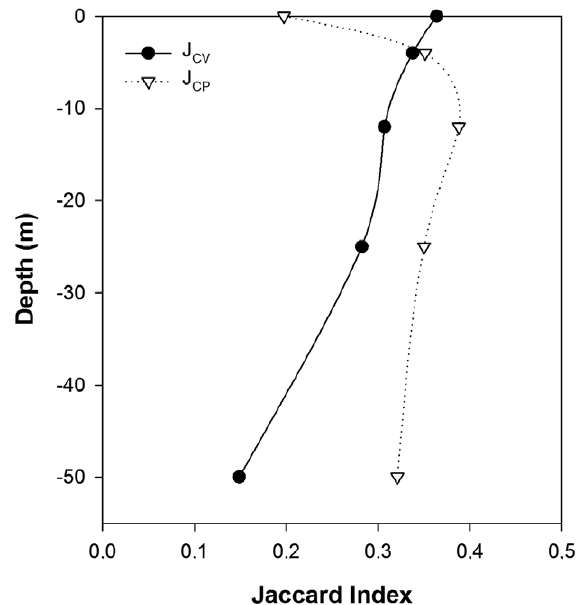
Fig. 3. – Qualitative similarity (Jaccard Index, J) between methods along the depth gradient: between the collection method and the in situ visual method (J ) and between the collection method and the CV photoquadrat method (J CP